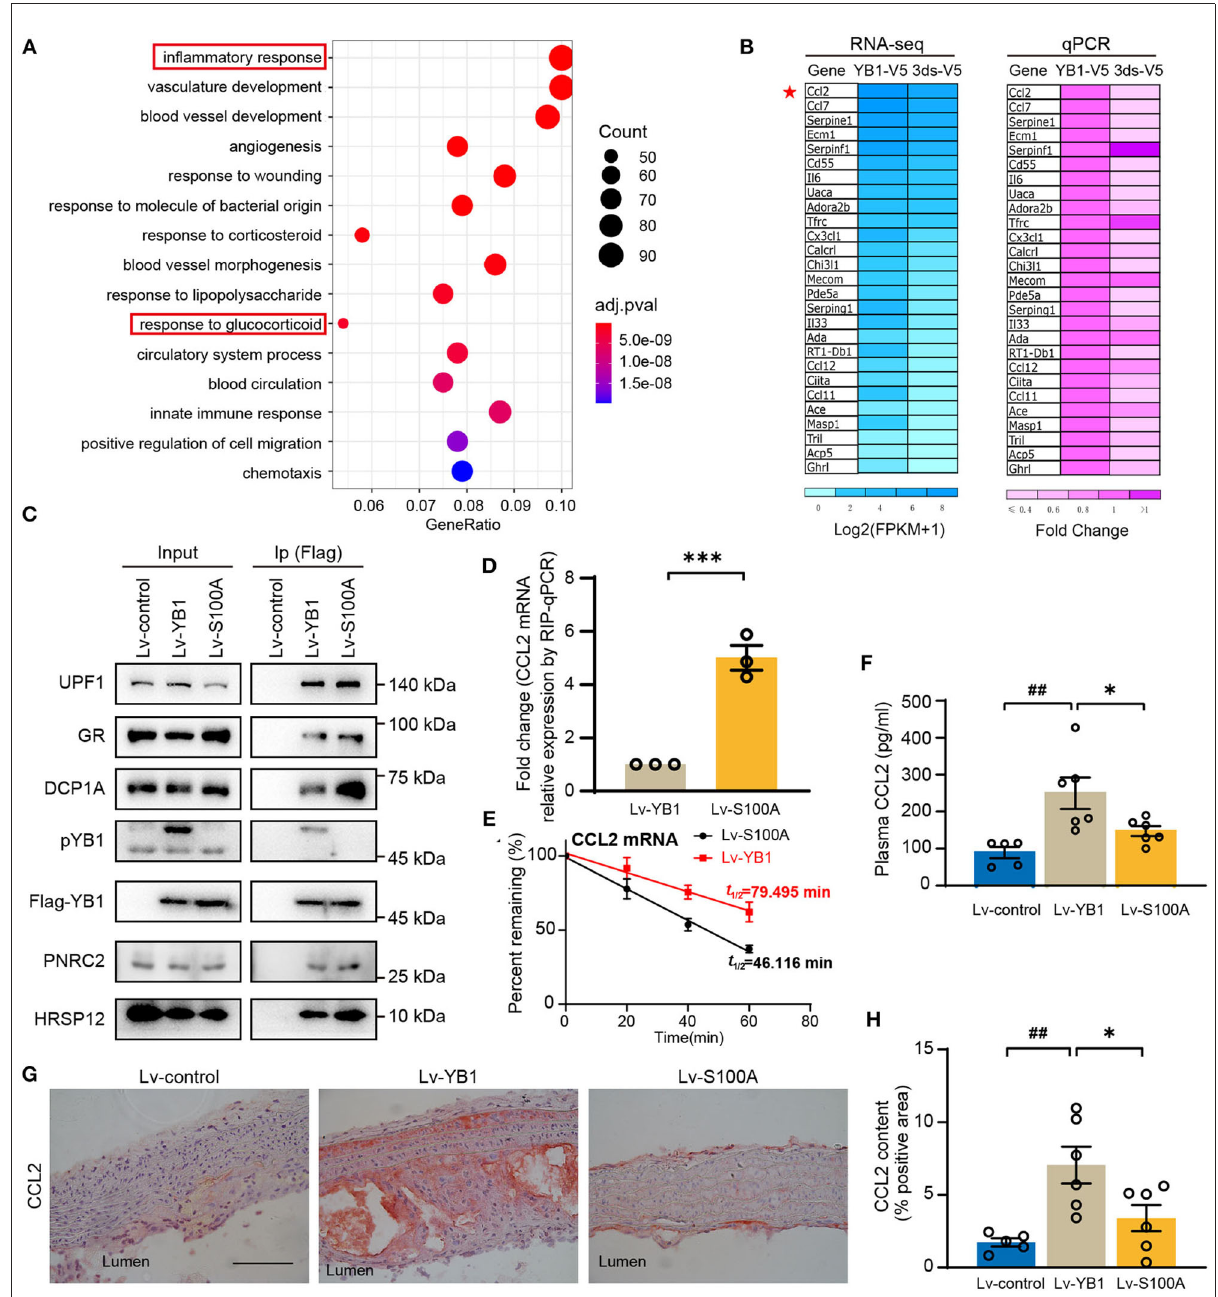
FIGURE5 YB1 dephosphorylation decreased CCL2 expression by promoting mRNA decay in SMCs. (A) Top 15 enriched Gene Ontology using DEGs between the YB-1-V5 and 3dS-V5 group; (B) Heatmap showing the expression of representative inflammatory-related genes in YB-1-V5 and 3dS-V5 group in the RNA-seq data and its validation by RT-qPCR, respectively. (C) Flag-tagged YB1 was immunoprecipitated using Flag M2 beads and subjected to the Western blot for the determination of the GMD (glucocorticoid receptor-mediated mRNA decay) complex. (D) Flag-tagged YB1 RIP followed by qPCR (RIP-qPCR) analysis between the Lv-YB1 and Lv-S100A group. (E) The half-live of CCL2 was decreased in the Lv-S100A group compared with the Lv-YB1 group. (F) Plasma CCL2 of ApoE − / − mice from Lv-control, Lv-YB1, Lv-S100A group. (G) Representative images of immunohistochemical staining of CCL2 in the mouse aortic arch from Lv-control, Lv-YB1, and Lv-S100A groups, and the related quantitative analysis, respectively (H) . Data are presented as the mean ± SEM. Statistics (D) : Student’s two-tailed t -test, (F,H) : One-way ANOVA. ## P < 0.01 vs Lv-control, * P < 0.05, *** P < 0.001 vs. Lv-YB1. Scale bar = 50 µ m ( n = 3 to 6 for each